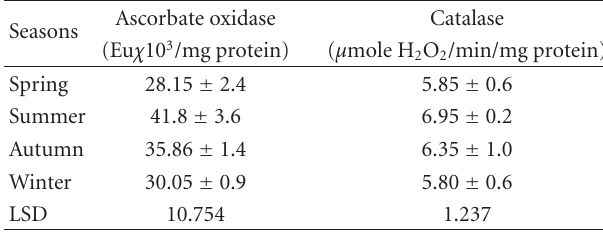
Table 9: Ascrobate oxidase and catalase content of Enteromorpha compressa collected in di ff erent seasons.